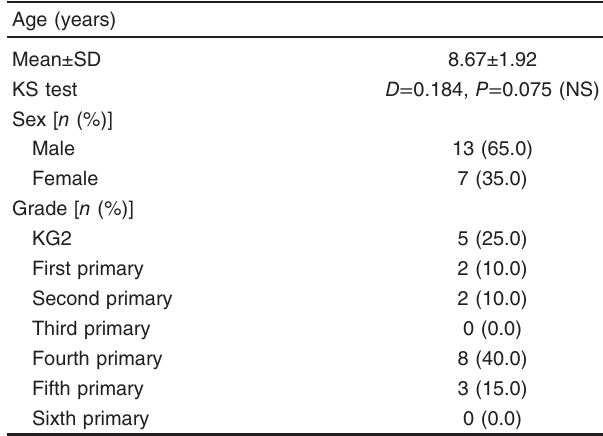
Table 1 Mean age, sex, type of school, grade, and preferred hand for the studied group